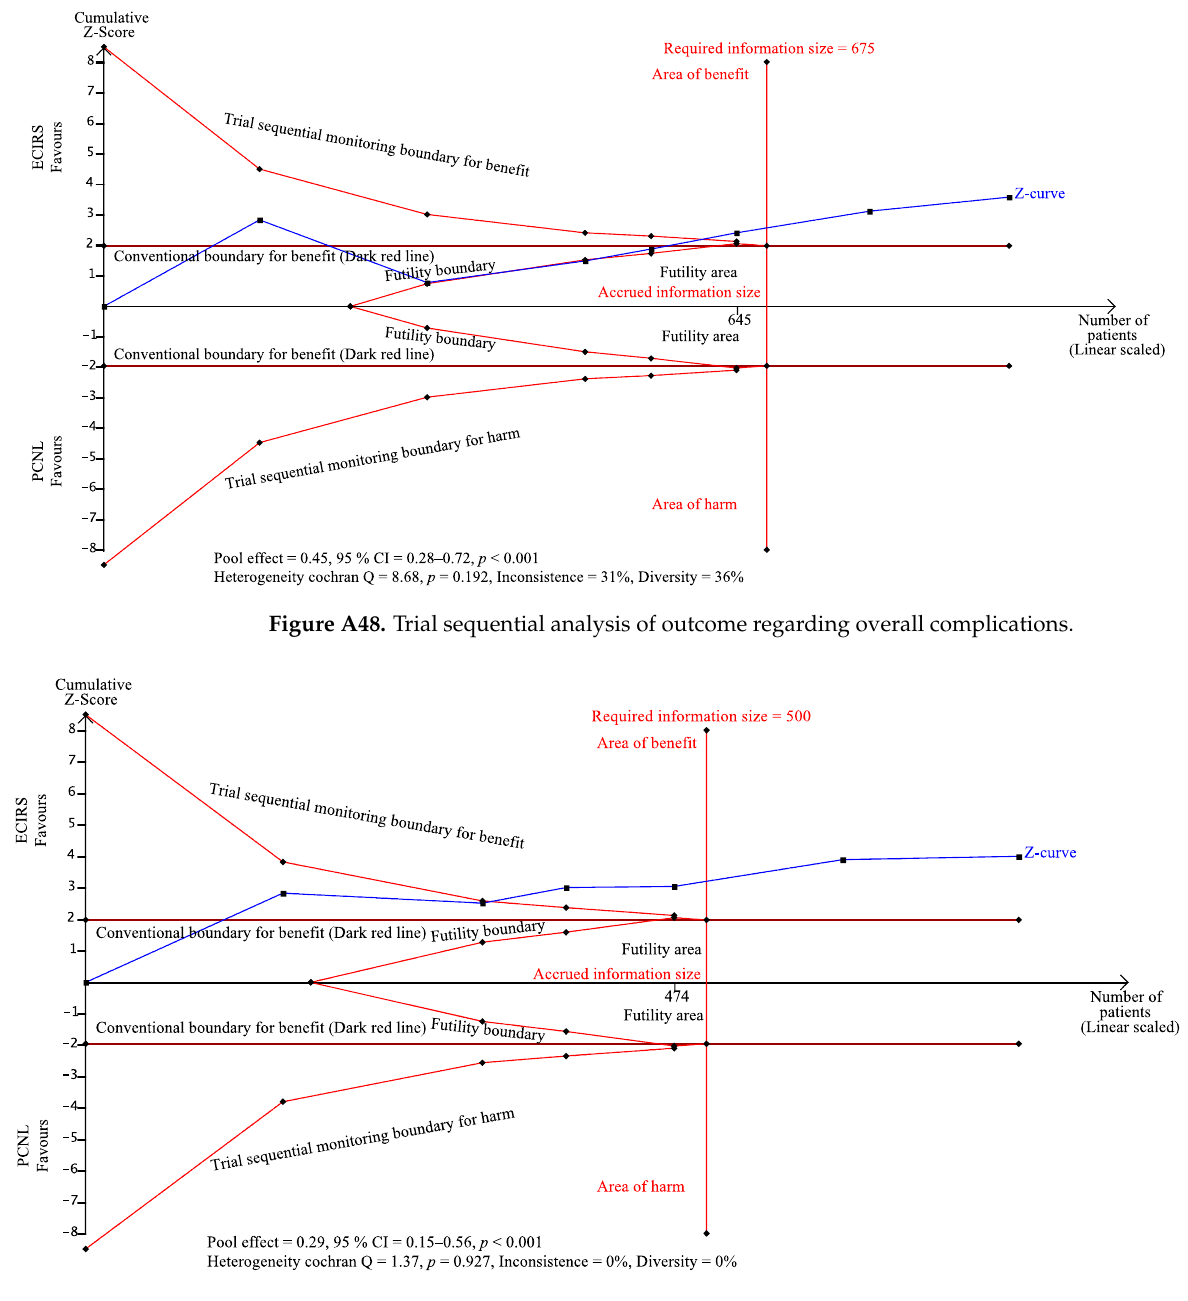
Figure A50. Trial sequential analysis of outcome regarding post-operative fever.